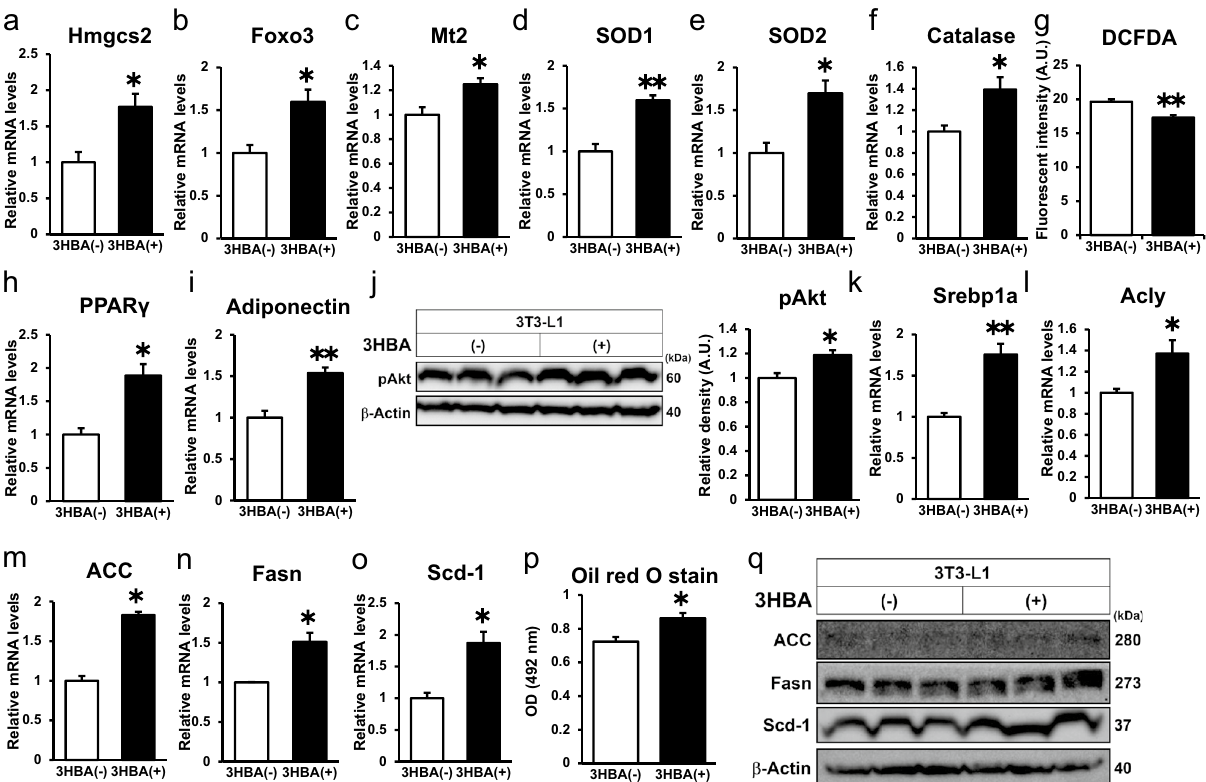
Figure 4. 3HBA exerts beneficial effects on adipocytes by reducing ROS levels via augmentation of antioxidative stress factors and inducing PPARγ, insulin signaling, and lipogenic factors in vitro. On day 7 after 3T3-L1 adipocytes were differentiated, the 3T3-L1 adipocytes were maintained in serum-free DMEM composed of 2.5 mM glucose and 0 mM or 10 mM 3HBA for 24 h. On day 8 after differentiation, the 3T3- L1 adipocytes were additively stimulated with 1 nM insulin for 24 h, followed by harvesting on day 9 after differentiation. ( a – f ) qRT–PCR of Hmgcs2 and antioxidative stress factors. n = 3. ( g ) Cellular ROS detected by 2’,7’-dichlorofluorescein diacetate (DCFDA) assay. n = 3. ( h and i ) qRT–PCR of PPARγ ( h ) and adiponectin ( i ). n = 3. ( j ) Western blot of pAkt and β-Actin. Left panel; Representative western blot analysis. Right panel; Quantitative analysis of pAkt in the left panel. n = 3. ( k – o ) qRT–PCR of lipogenic factors. n = 3. ( p ) Oil red O stain (OD = 492 nm). n = 3. ( q ) Western blot of lipogenic factors and β-Actin. n = 3. Here cropped blots were displayed and all full-length blots are included in the Supplementary Figure S4. Data are mean ± SEM. * p < 0.05, ** p < 0.01. A.U., Arbitrary